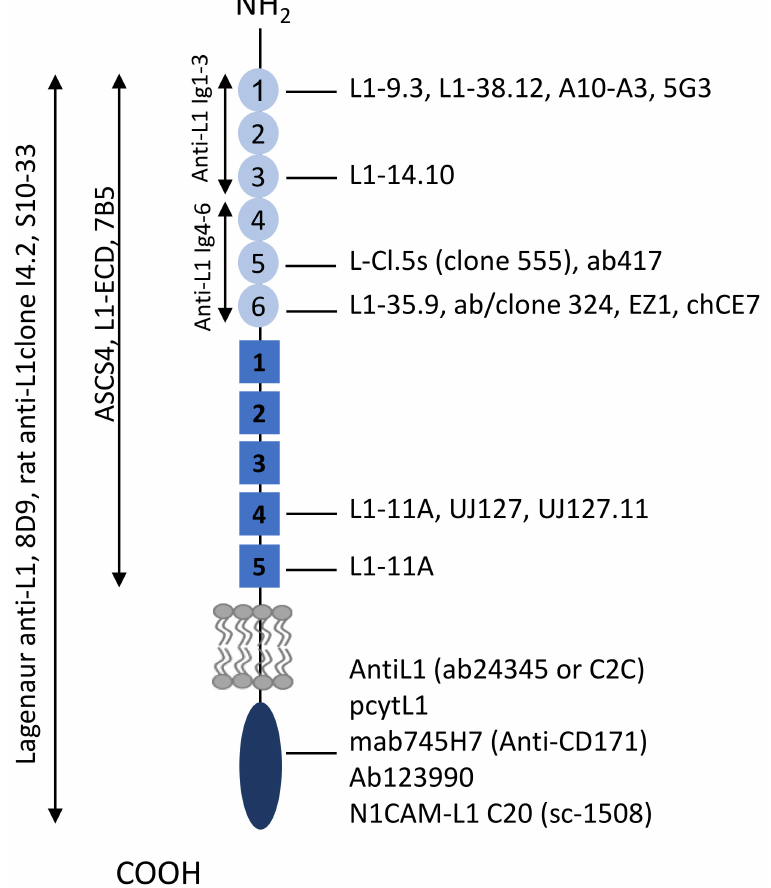
Figure 4. Overview of epitopes of anti-L1CAM antibodies. See Figure 1 for an overview of amino acid sequences corresponding with the indicated